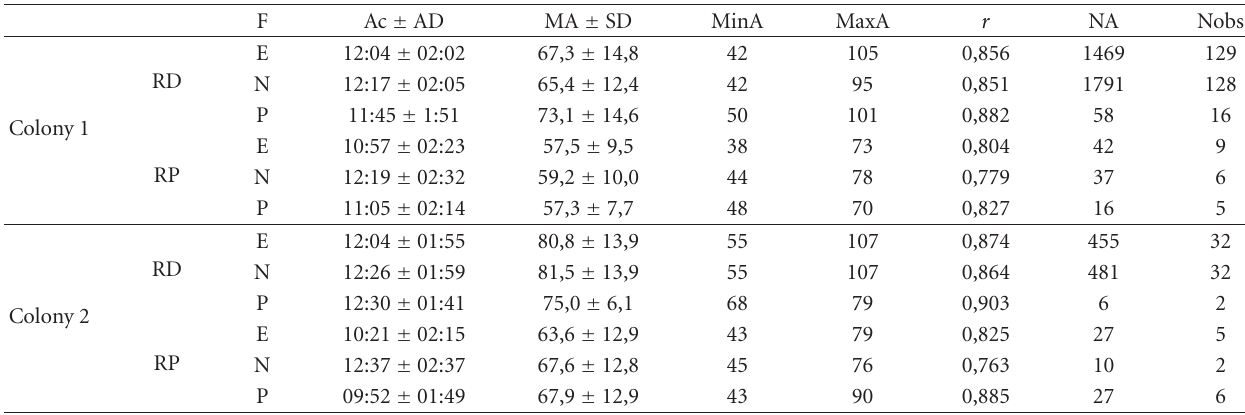
Table 4: Acrophases (Ac; hr:min) and angular deviations (AD; hr:min), mean ages (MA; days), standard deviations (SD; days), minimum (MinA) and maximum ages (MaxA), mean vectors ( r ), number of activities (NA), and number of marked bees observed (Nobs) in the nectar (N) and pollen (P) foraging (F) and in the exit (E) of the marked bees of colonies 1 and 2 of Plebeia remota , in the reproductive diapause (RD) and reproductive phase (RP).